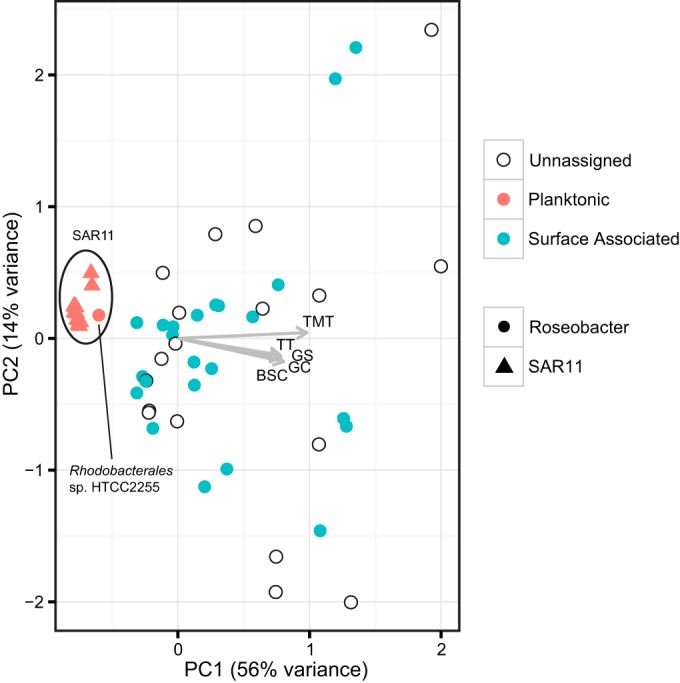
Ordination plot of a principal components analysis (PCA) based on the diversity and abundance of trace metal transporters in Roseobacter (circles) and SAR11 (triangles) genomes, as presented in Fig. 1. The 42 Roseobacter genomes and 22 SAR11 genomes are plotted with respect to whether the organism has been observed to be surface associated (blue) or planktonic (red) or there is insufficient data to assign a lifestyle (white). Arrows represent fitted vectors of continuous associated variables (genome features) and show the direction of the increasing gradient. Arrow length is proportional to the correlation between the variable and ordination. TMT, total number of metal transporters per genome (R2 = 0.96, P = 0.001); TT, total number of transporters per genome (R2 = 0.71, P < 0.001); BSC, total number of predicted biosynthetic gene clusters per genome (R2 = 0.63, P < 0.001); GC, GC content per genome (R2 = 0.67, P < 0.001); GS, total number of predicted genes per genome (R2 = 0.63, P < 0.001).